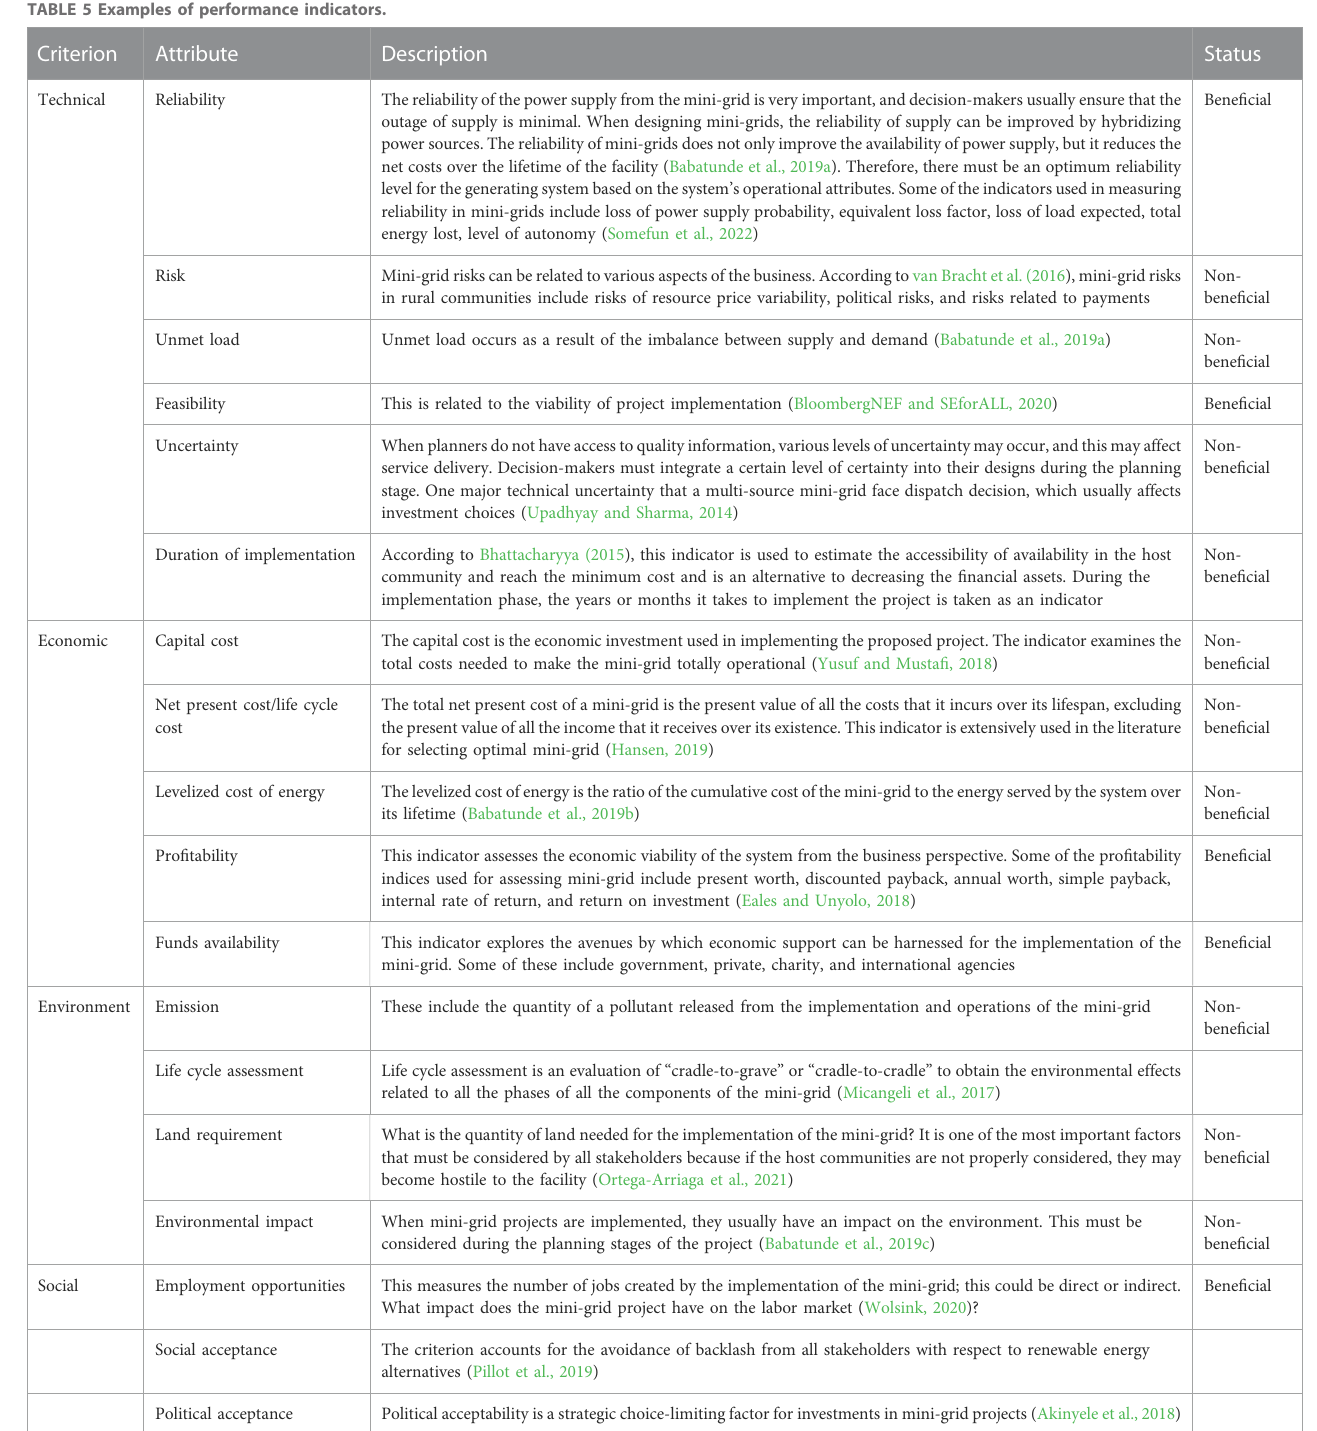
TABLE 5 Examples of performance